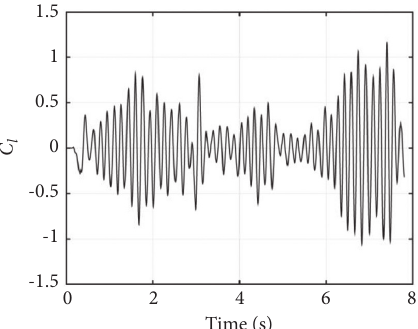
Figure 7: Time history of lift coefficient (with spoilers).